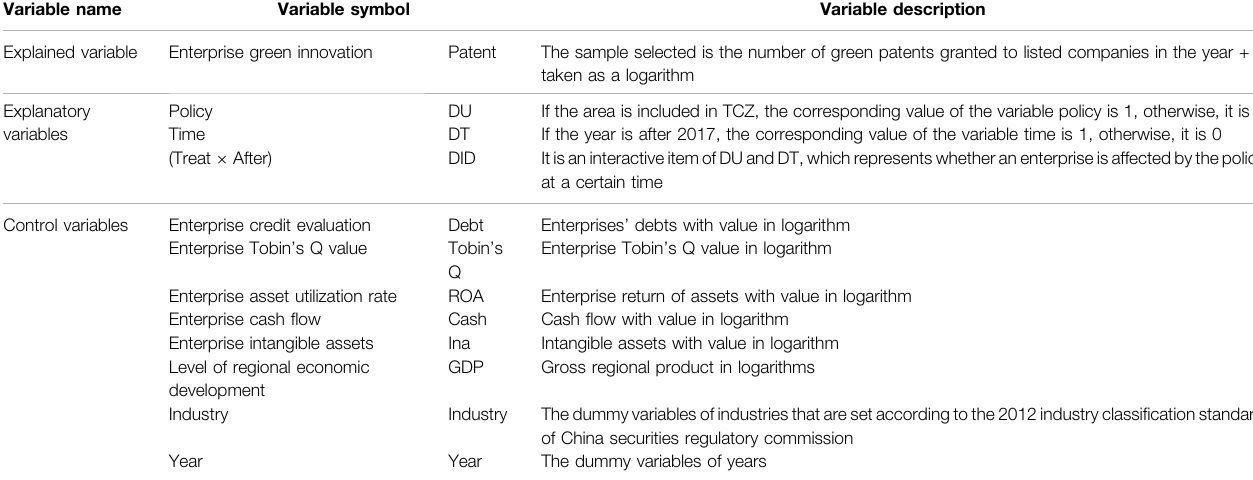
TABLE 1 | Variable de fi nition. Variable